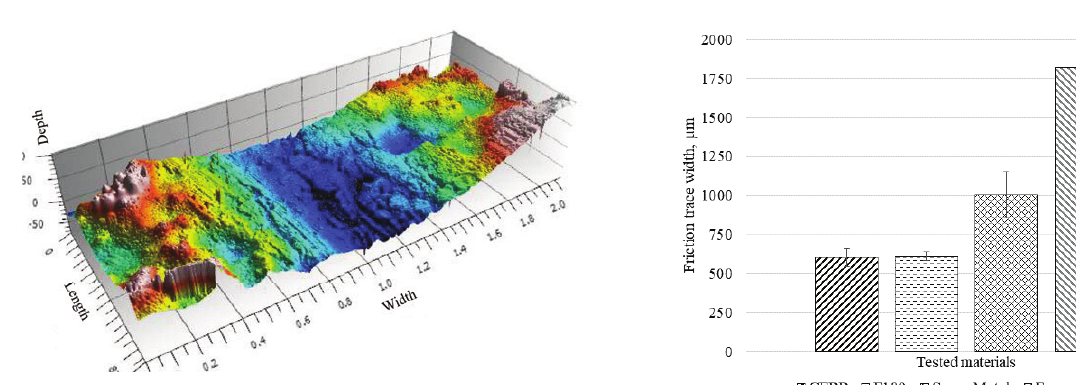
Figure 10. 3D scan of the friction path surface for Super Metal material